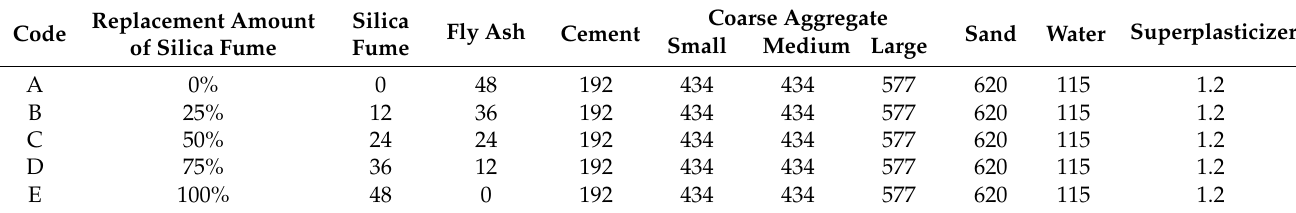
Table 4. The mix proportions of concrete (kg/m 3